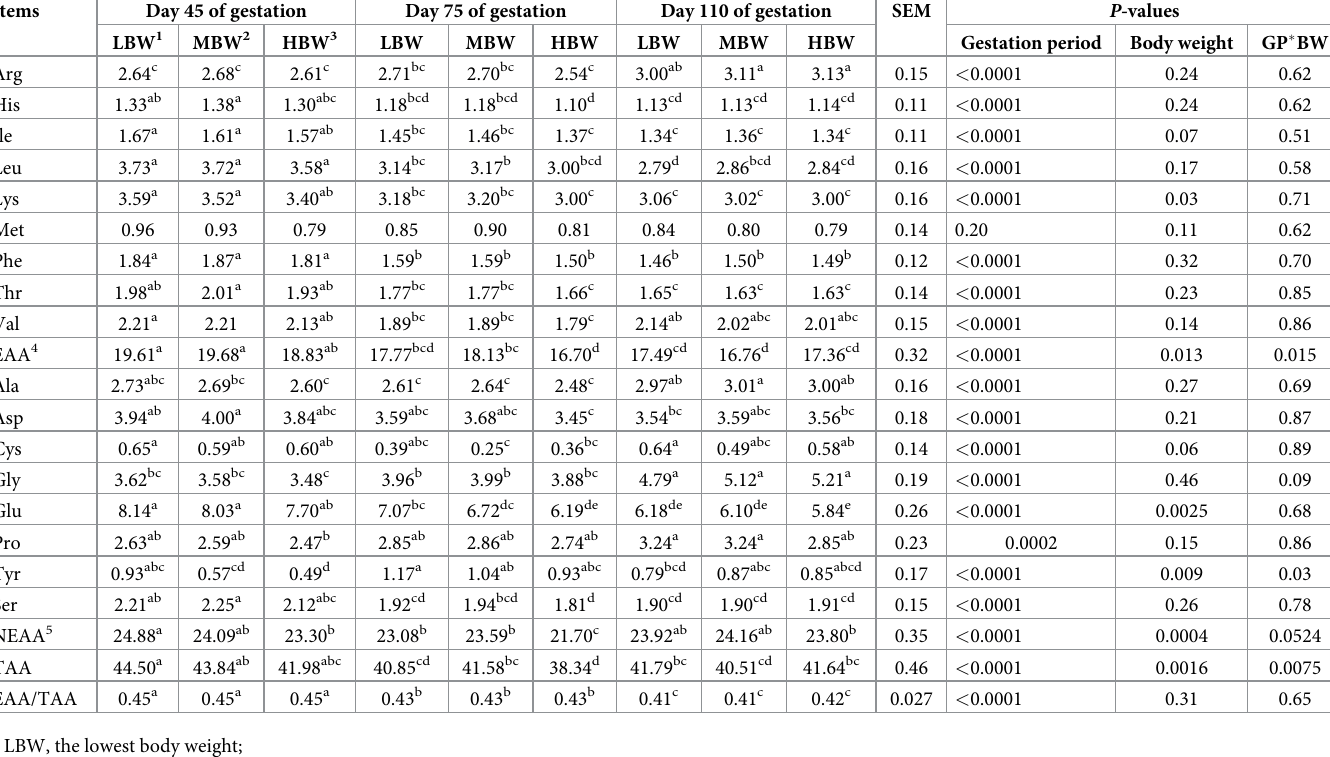
Table 5. Composition of hydrolyzed amino acids of fetal pigs with LBW, MBW, and HBW at different gestation period (g/100g; n = 8).